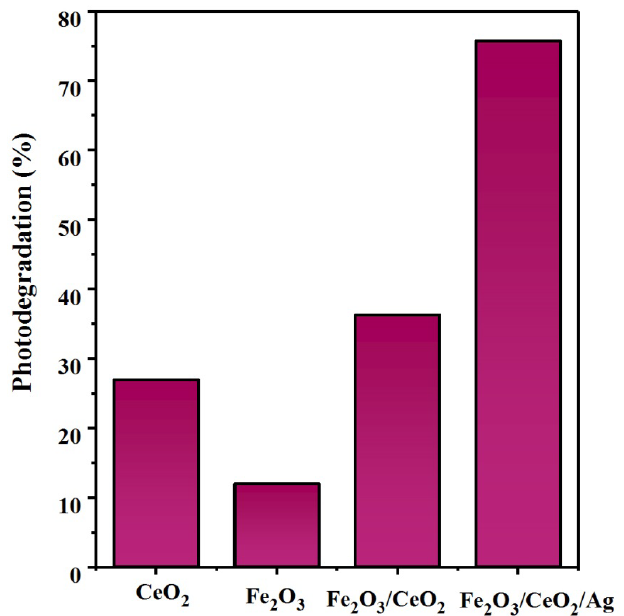
, Fe O , Fe O /CeO 2 2 3 2 3